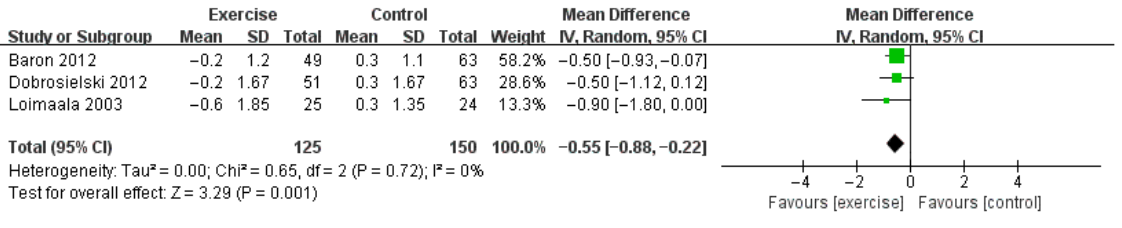
Figure 6. The pooled result of the difference of changes in hemoglobin A1c between two groups [35 –